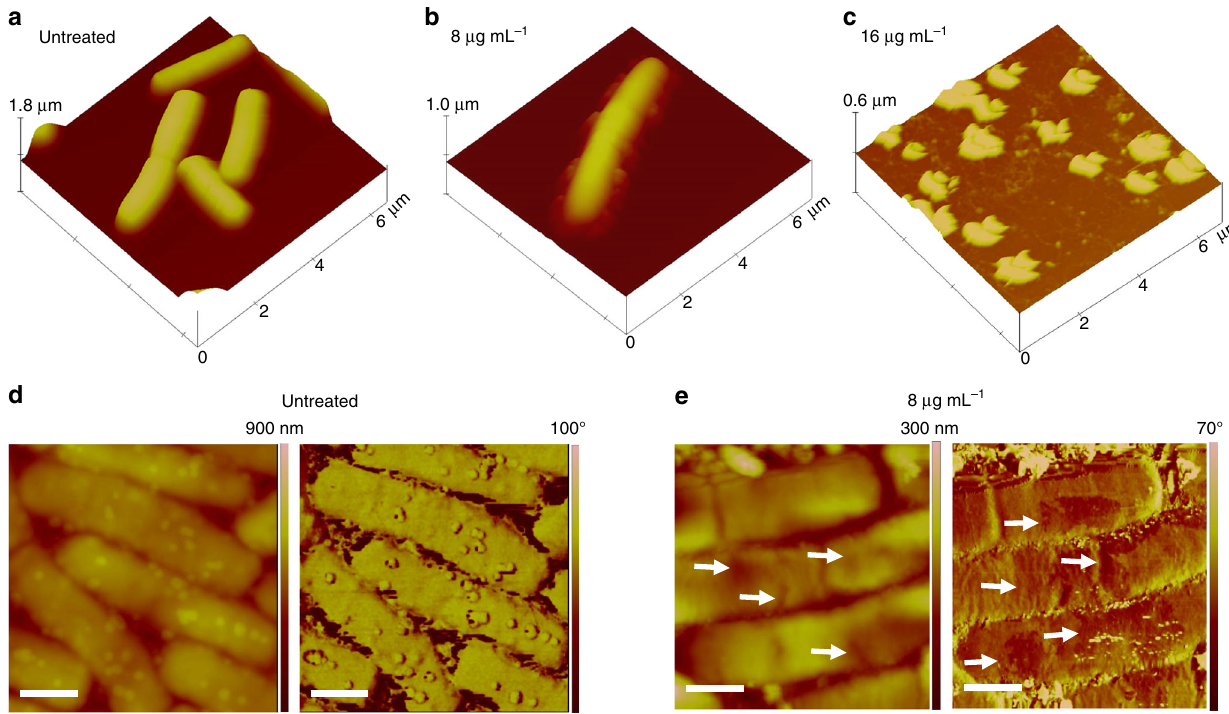
Fig. 2 Tapping TM mode AFM imaging of B. cereus deposited on mica surface. a , d Depictions of B. cereus before the exposure of compound 1 , whereas b , c , and e show the bacteria in the presence of compound 1 . a – c 3D representations of topographic images, whereas d and e (scale bars = 750 nm) are detailed topographic (left panels) and phase-contrast (right panels) images of untreated cells and upon interaction with glycoside 1 (8 μ g mL − 1 ), respectively. The arrows indicate lesions in the cellular